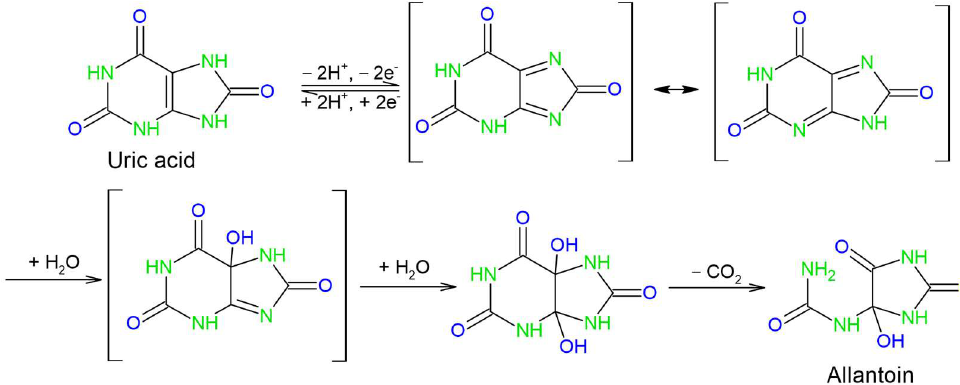
Figure 2. ( A ) Optimization of pH of the 0.1 M PB supporting electrolyte from pH 2 to pH 9. ( B ) CV in 0.1 M PB pH 6 in the potential range from −0.5 V to 1 V at the scan rates from 2 mV/s to 100 mV/s. (inset B) Linear plot of oxidation peak current vs. scan